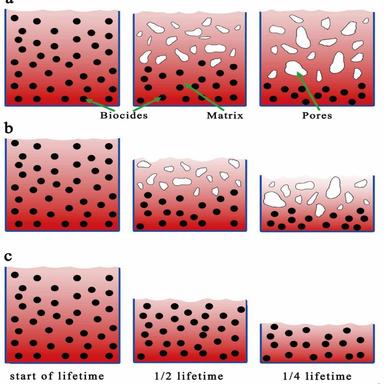
Release kinetics of three biocide-based antifouling coatings: (a) contact leaching coating, (b) controllable depletion coating, (c) self-polishing coating. Copyright © 2009 Woodhead Publishing Limited.